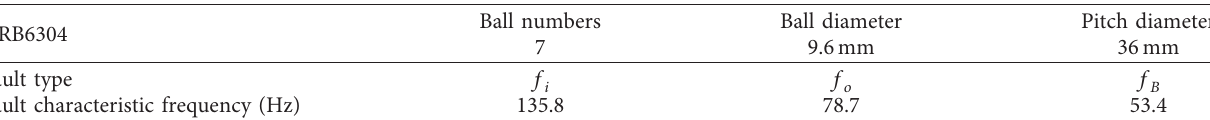
Figure 27: Aero engine rotor-bearing fault simulator. Table 6: Geometry and characteristic frequencies of the test